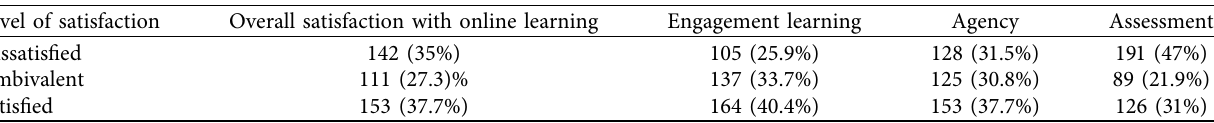
Table 4: Percentage of undergraduate students in general satisfaction, satisfaction in engagement learning, agency, and assessment of online learning ( N � 406).